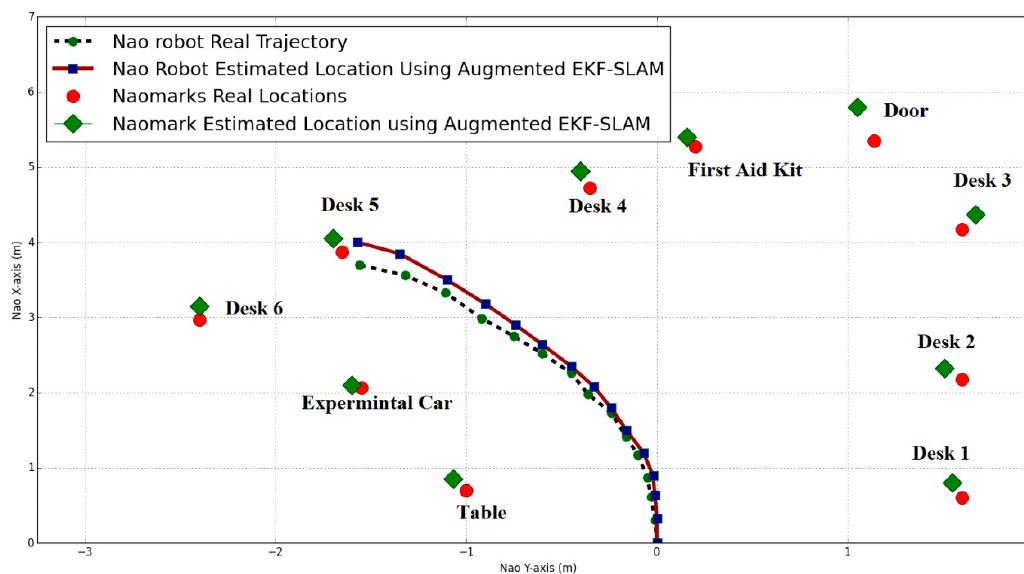
Figure 18. NAO location and NAO marker positions using augmented EKF SLAM.